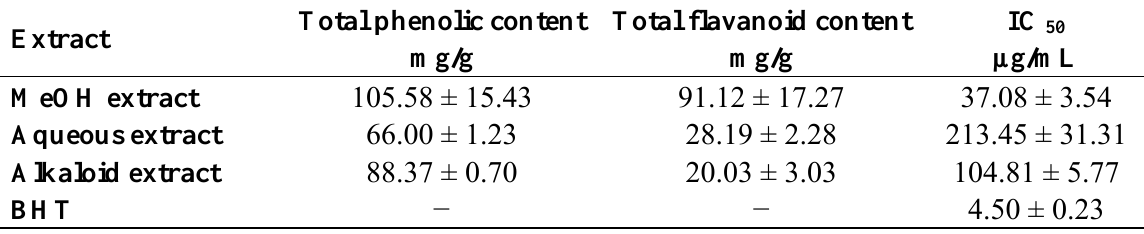
Table 1. The total phenolic, flavanoid content and DPPH IC speciosa leaf